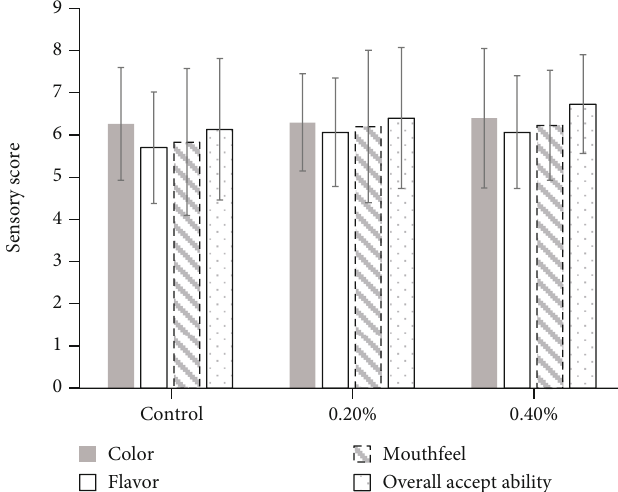
Figure 1: E ff ect of Momordica cochinchinensis aril extract on anticancer activities. (a) and (b) represent the toxic activities of human skin keratinocyte cell line and normal human dermal fi broblast, respectively. (c) and (d) represent the anticancer activities against human lung adenocarcinoma cell line A 549 and human melanoma cell line A 375, respectively. Data are presented as means ± SD ( n = 5 ). Statistical comparisons were made between samples using one-way ANOVA